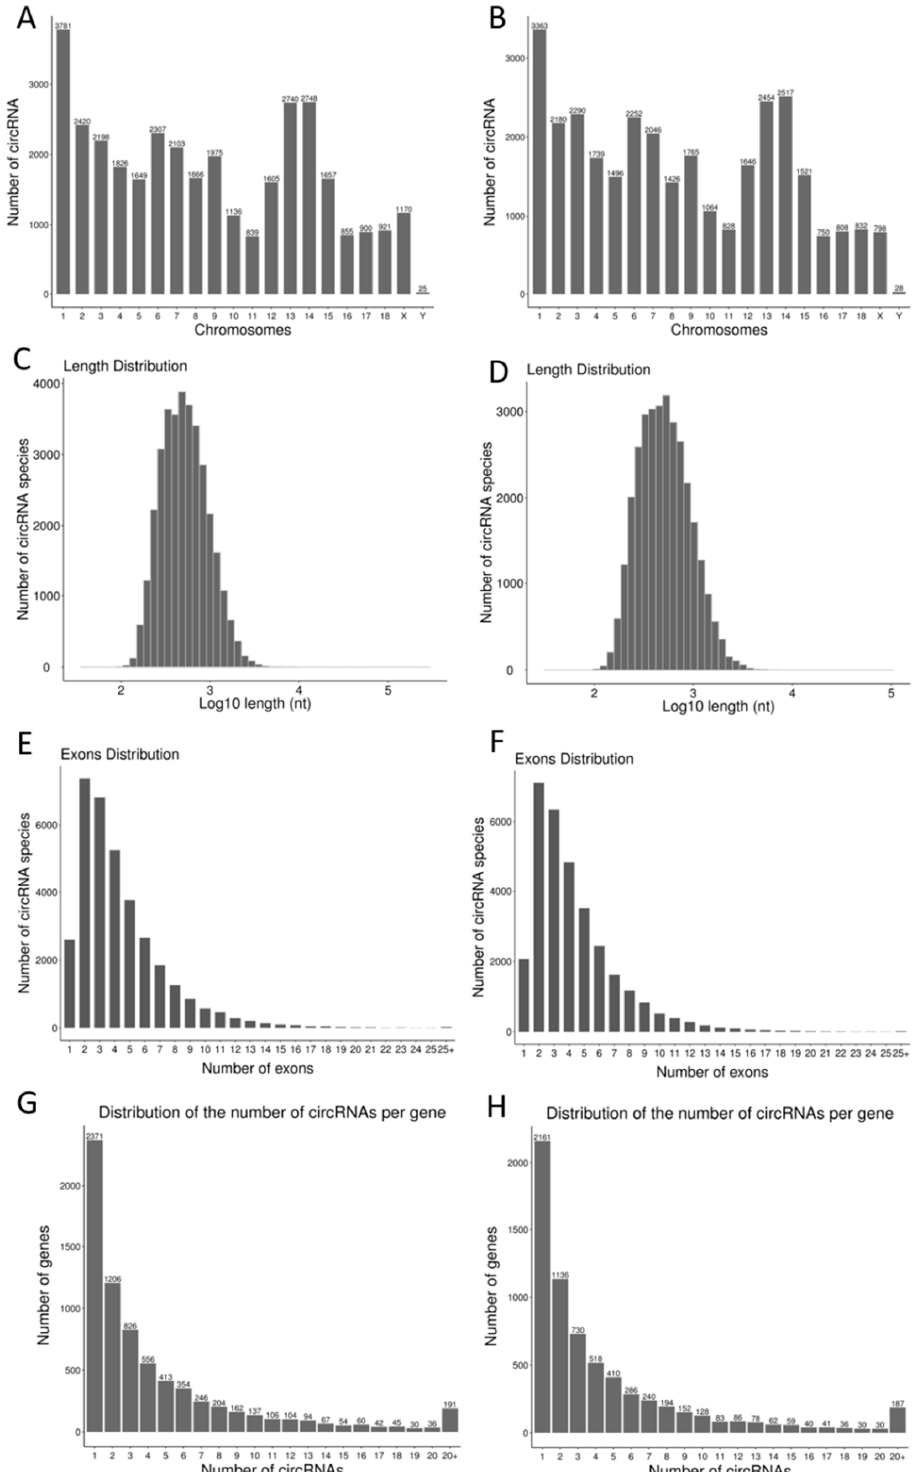
Figure 3. Comparison of basic characteristics of circRNA in testes tissues of young (Piglet-D30) and sexually mature (Adult-D210) boars. Distribution of circRNAs on chromosomes in testis tissues of young and sexually mature Landrace breeding boars ( A , B ). Length distributions of circRNA in testis tissues of young and sexually mature Landrace breeding boars ( C , D ). Analysis of the number of exons contained in exon circRNA in the testis tissues of young and sexually mature Landrace breeding boars ( E , F ). Number of circRNAs produced by genes of different origin in the testis tissues of young and sexually mature Landrace breeding boars ( G , H